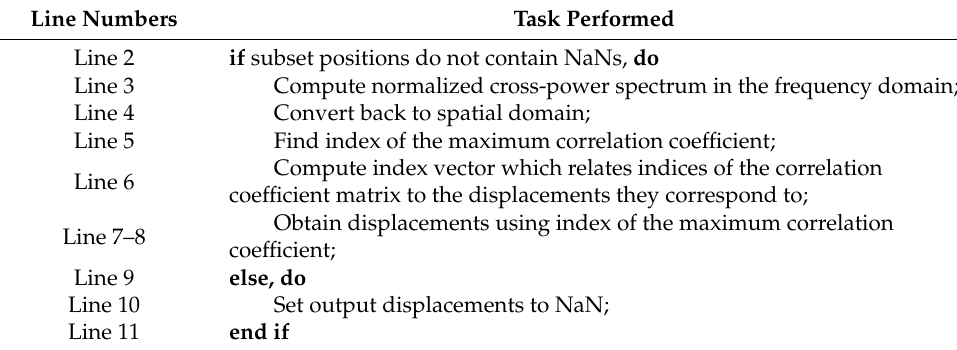
Table 11. PCM algorithm